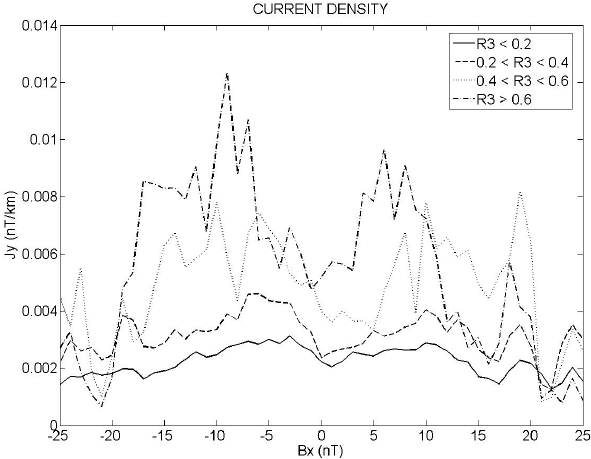
Fig. 7. The electric current density distributions j y (B x ) for differ- ent temperature anisotropy ratios R 2 .